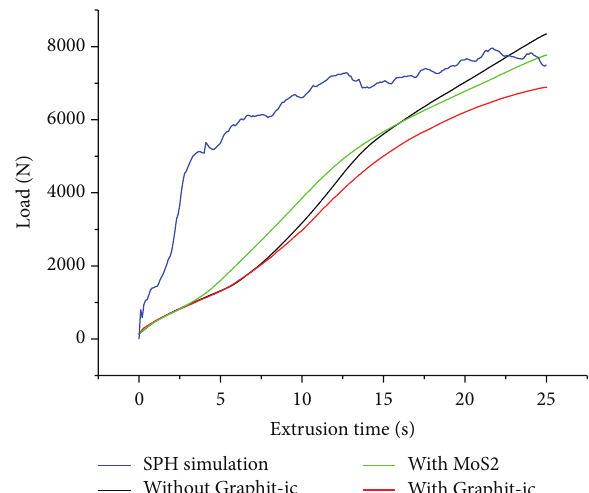
Figure 5: Load-time curves of extrusion (SPH simulation, without Graphit-ic coating, lubricate with MoS2, and lubricate with Graphit- ic